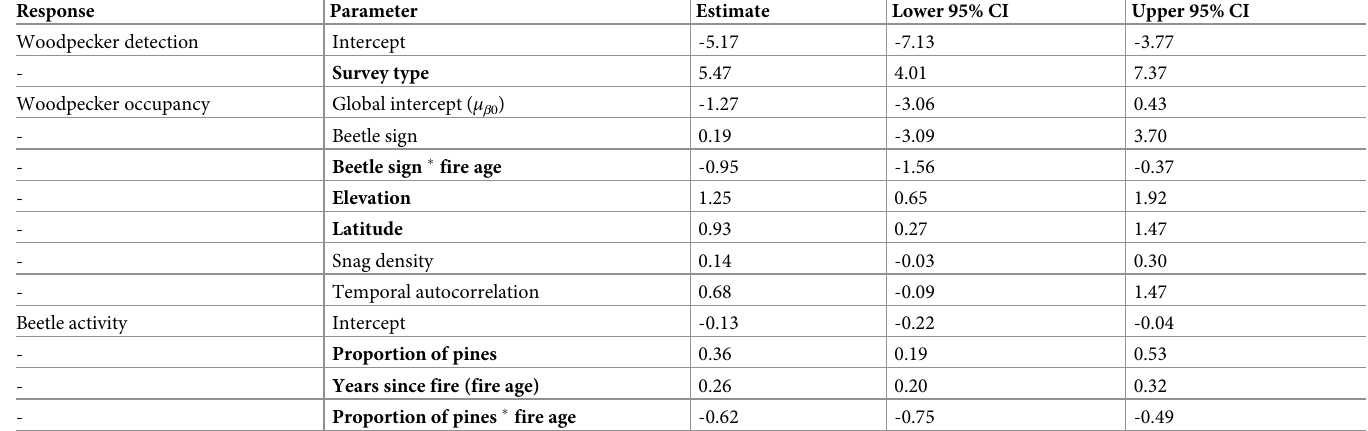
Table 2. Posterior estimates of model parameters. Slope parameters with 95% Bayesian credible intervals that do not cross zero suggest relationships for which we have strong evidence and are highlighted in bold.